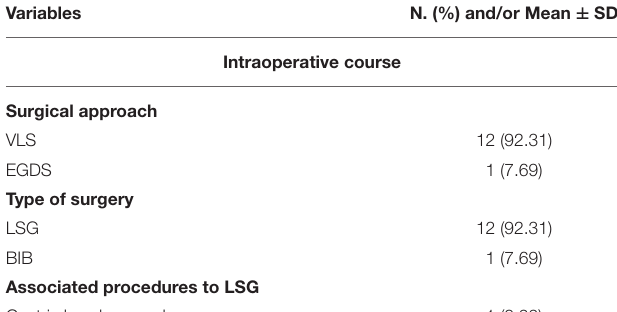
TABLE 1 | Baseline characteristics of patients. TABLE 2 | Intraoperative and postoperative course.